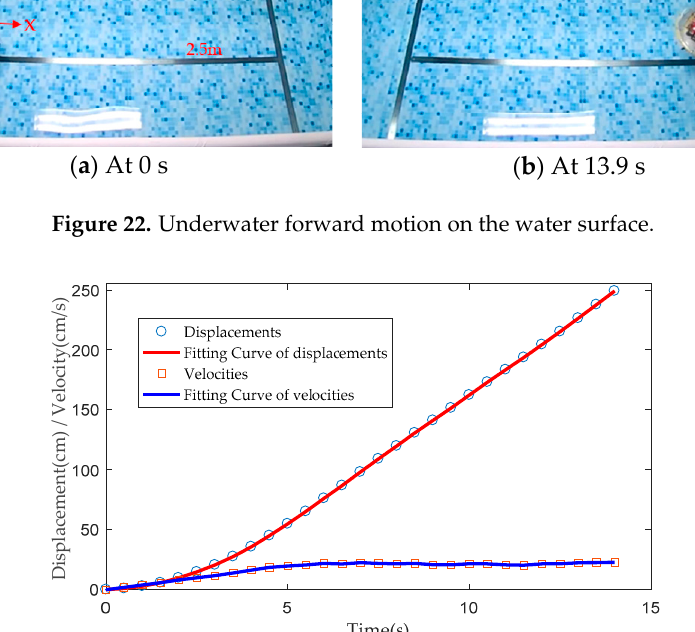
Figure 23. Experimental results for forward motion.